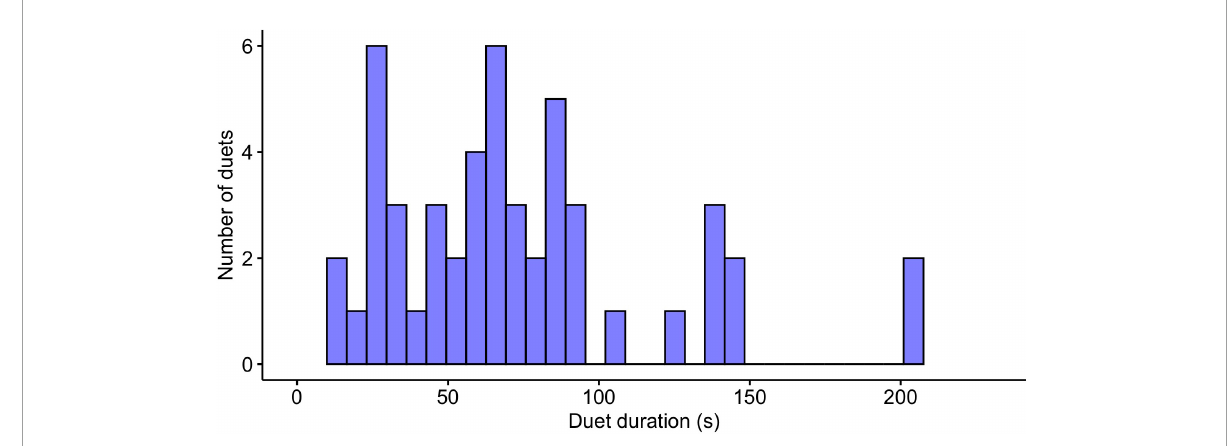
FIGURE4 Histogram indicating the durations of tarsier duets ( N = 50). Duets ranged in duration from 12.88 to 203.96 s and show a distribution with a slight right skew.